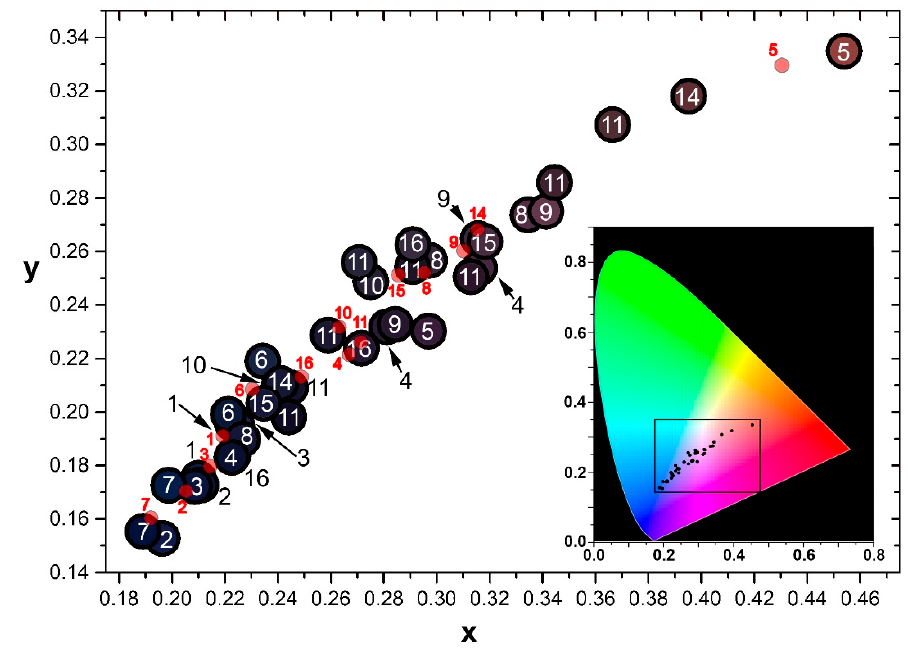
Figure 4. Position of the color clusters in an xy chromaticity diagram with indication of the corre- sponding sample. The position of the average pixels for all the images is also represented in red. Inset: A colored complete chromaticity diagram with indication of the color cluster position (black dots) and the rectangle corresponding to the part of the diagram depicted in the main figure.